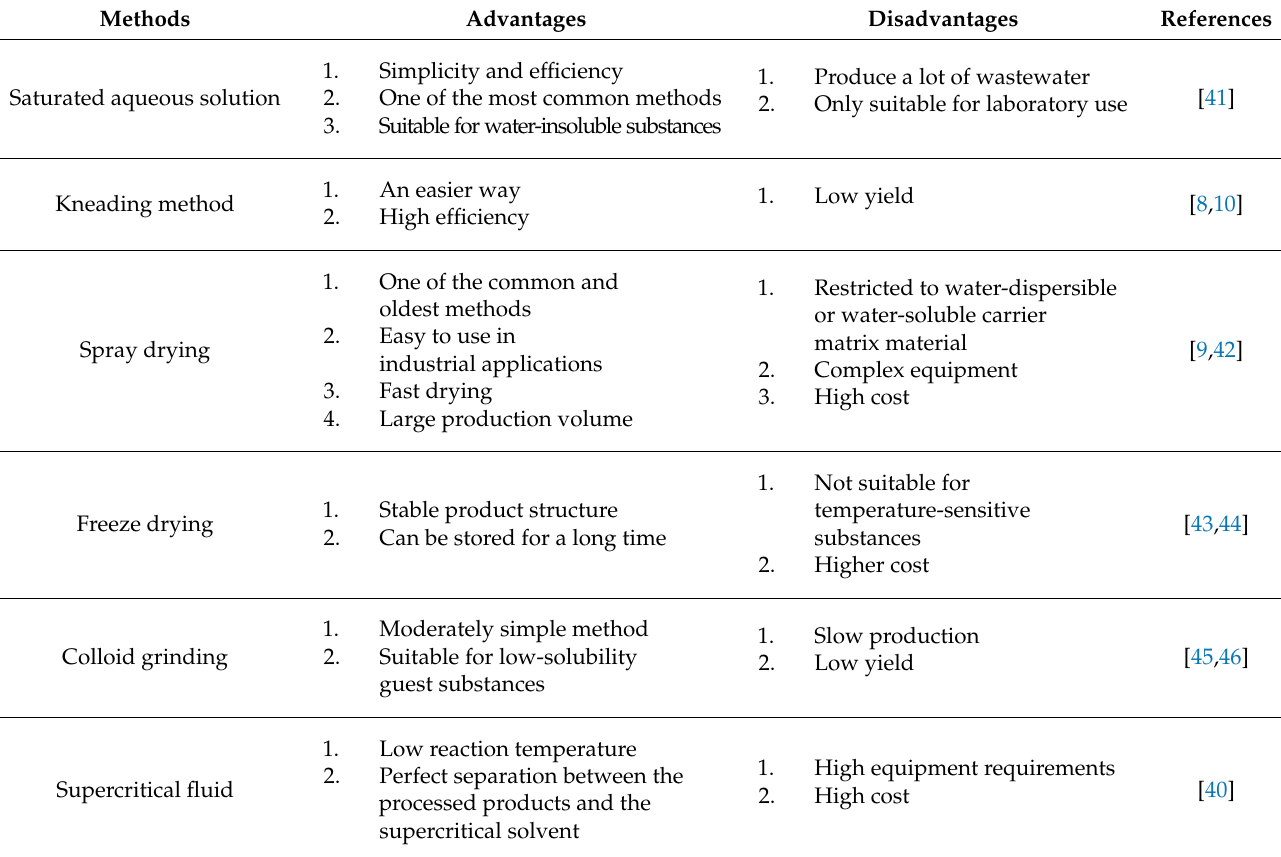
Table 2. Advantages and some drawbacks of the methods to prepare inclusion complexes (for more information, please see the associated